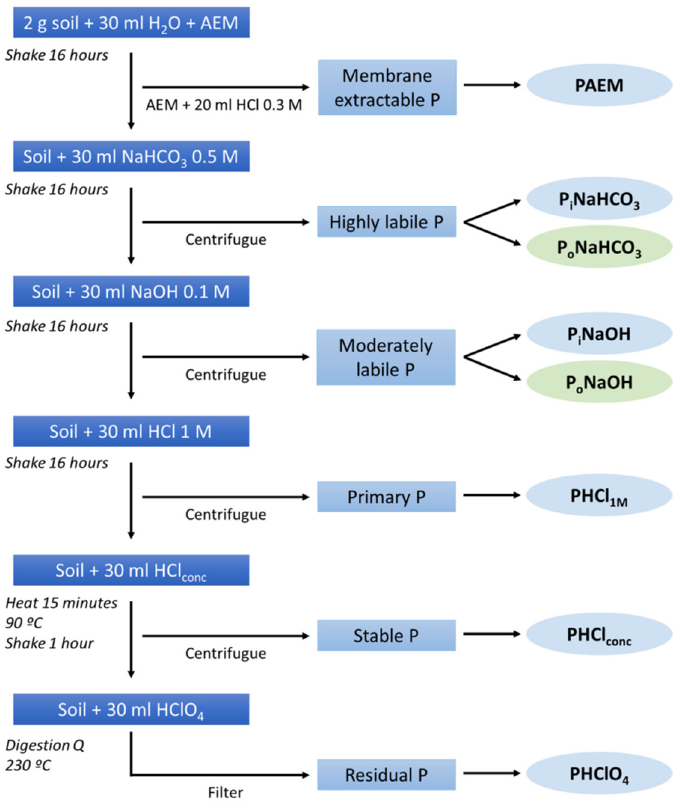
Figure 1. Scheme of the sequential phosphorus extraction procedure used in this study (modified from [43]). AEM: anion exchange membrane; Pi: inorganic P; Po: organic P; HClconc: concentrated HCl. Organic P fractions are indicated with green color.